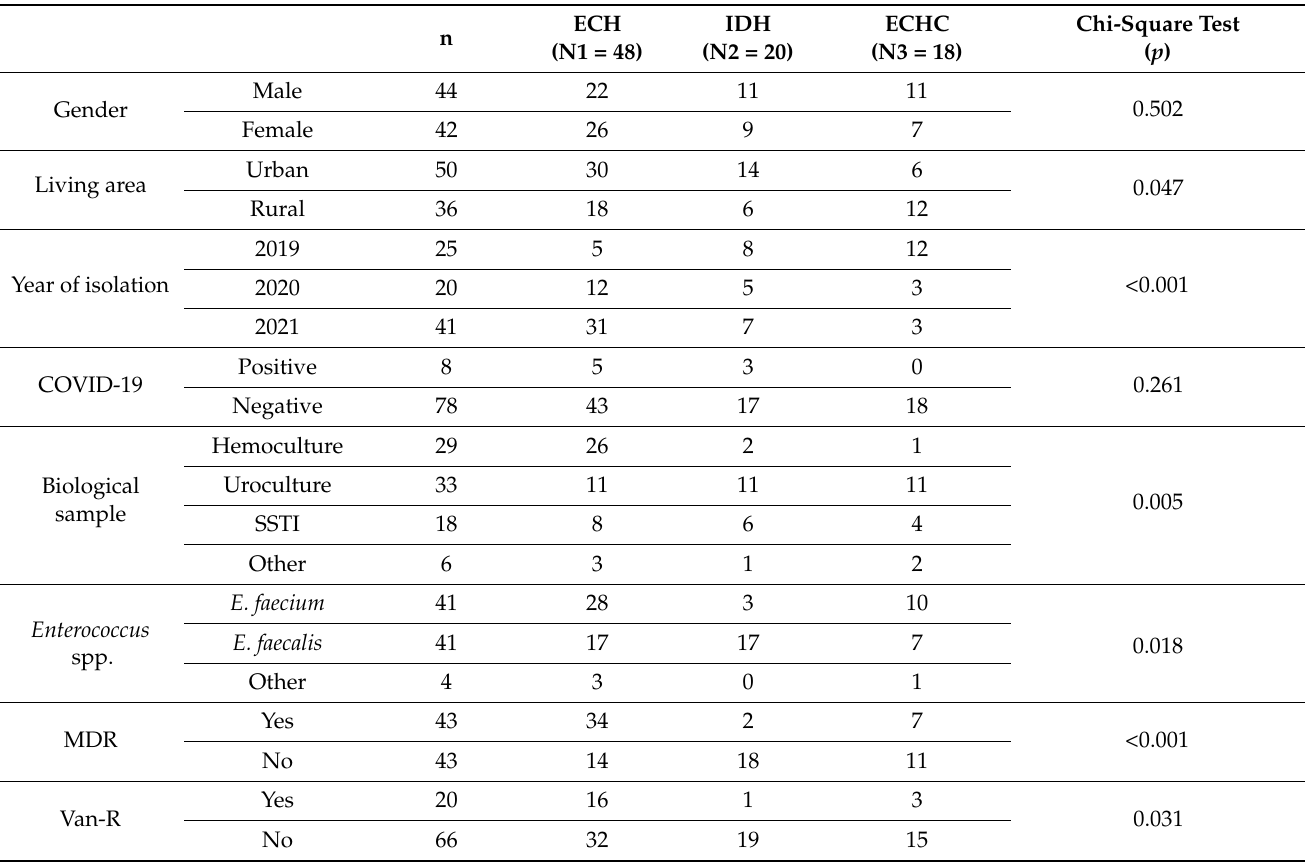
Table 2. Comparison of Enterococcus spp. in three hospitals of southeast